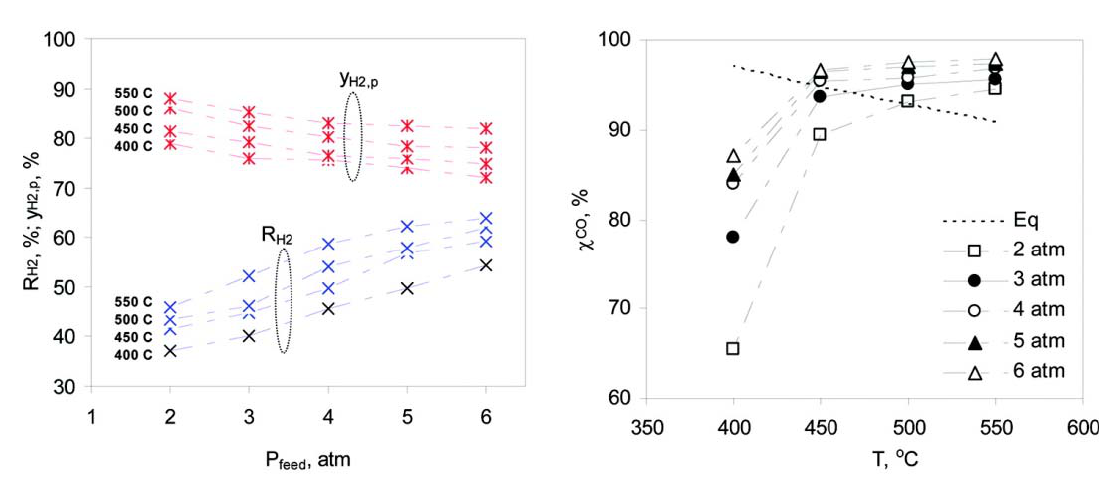
Figure 5. Water gas shift (WGS) reaction in a MFI zeolite membrane reactor (sweep: N 2 , at atmospheric pressure, WHSV at 7500 h − 1 and ratio of H 2 O/CO = 3.5): Influence of reaction ), hydrogen recovery (cid:4666)(cid:1844) pressure and temperature on CO conversion ( χ (cid:4667) and permeate (cid:3030)(cid:3042) (cid:3009) (cid:3118) side H 2 concentration (cid:4666)γ (cid:4667) . Reprinted with permission from [154]. (cid:3009) (cid:3118),(cid:3291)